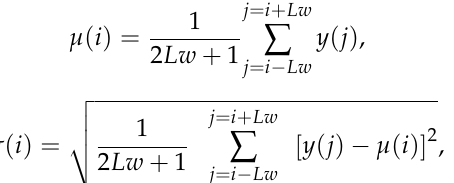
Figure 13. Probability distribution of the commencement of B1-cylinder exhaust valve closing impact in 480 combustion cycles with different values of k.